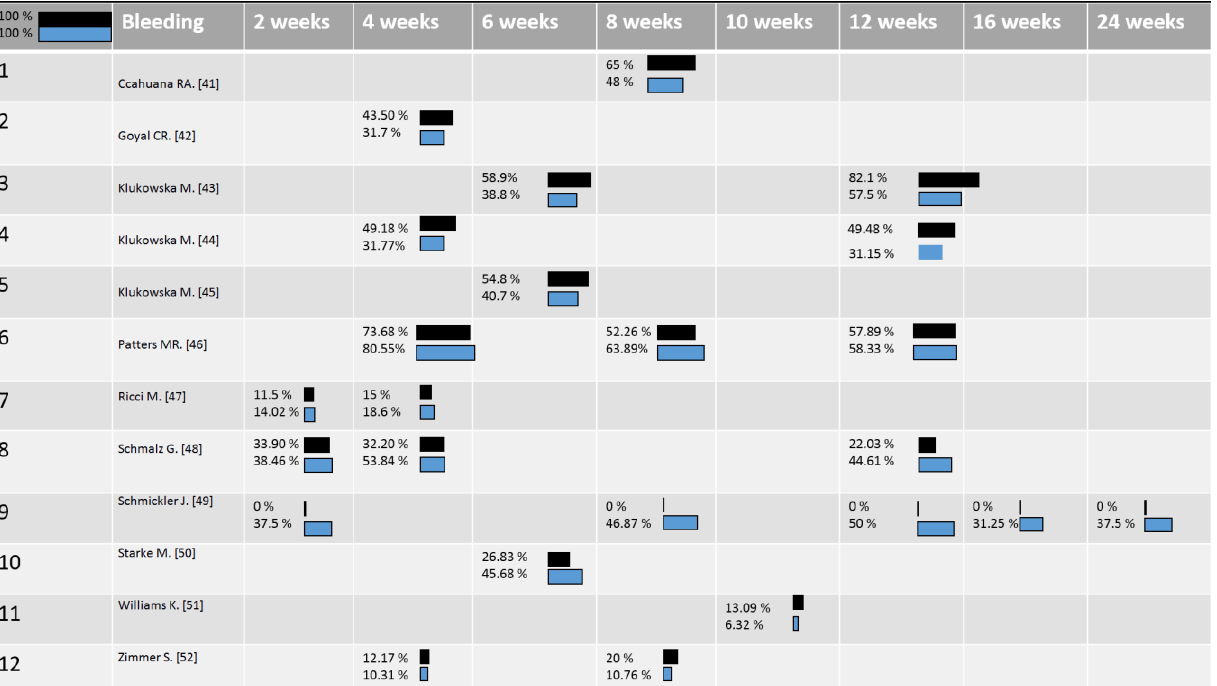
Figure 4. Plaque Index, the mean values of Plaque Index (changes) in relation to the number of patients in each study at each time-point: blue color corresponds to ORHs and black to SAHs toothbrushes [41–52].